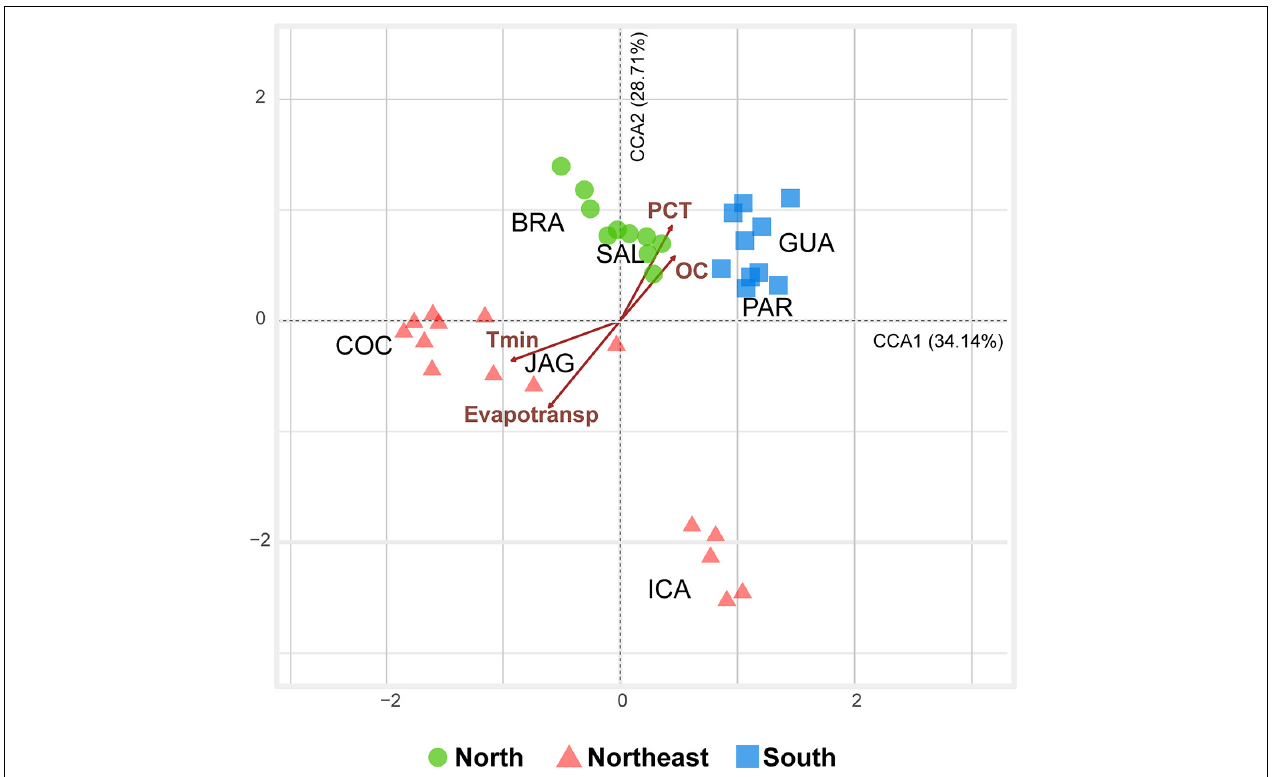
FIGURE 6 | Triplot diagram of the canonical correspondence analysis (CCA) calculated from the dataset containing 35 samples (five sampling points from each mangrove) containing only significant explanatory variables ( P < 0.05) and prokaryotic ASV composition for samples from the seven studied mangroves [BRA = Bragança (N); SAL = Salinópolis (N); COC = Cocó (NE); JAG = Jaguaribe (NE); ICA = Icapuí (NE); GUA = Guaratuba (S); and PAR = Paranaguá (S)]. CCA 1 ( F = 3.0563, P = 0.001) and CCA 2 ( F = 2.5695, P = 0.001) axes were significant and explained 62.85% of the data. Abbreviated abiotic variables: Tmin (Minimum Temperature); PCT (Precipitation); Evapotrans (Potential Evapotranspiration); and OC (Organic